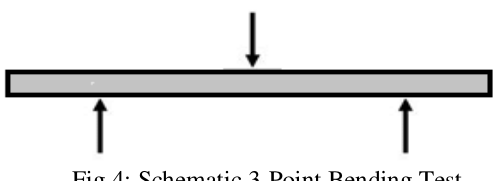
Fig 4: Schematic 3-Point Bending